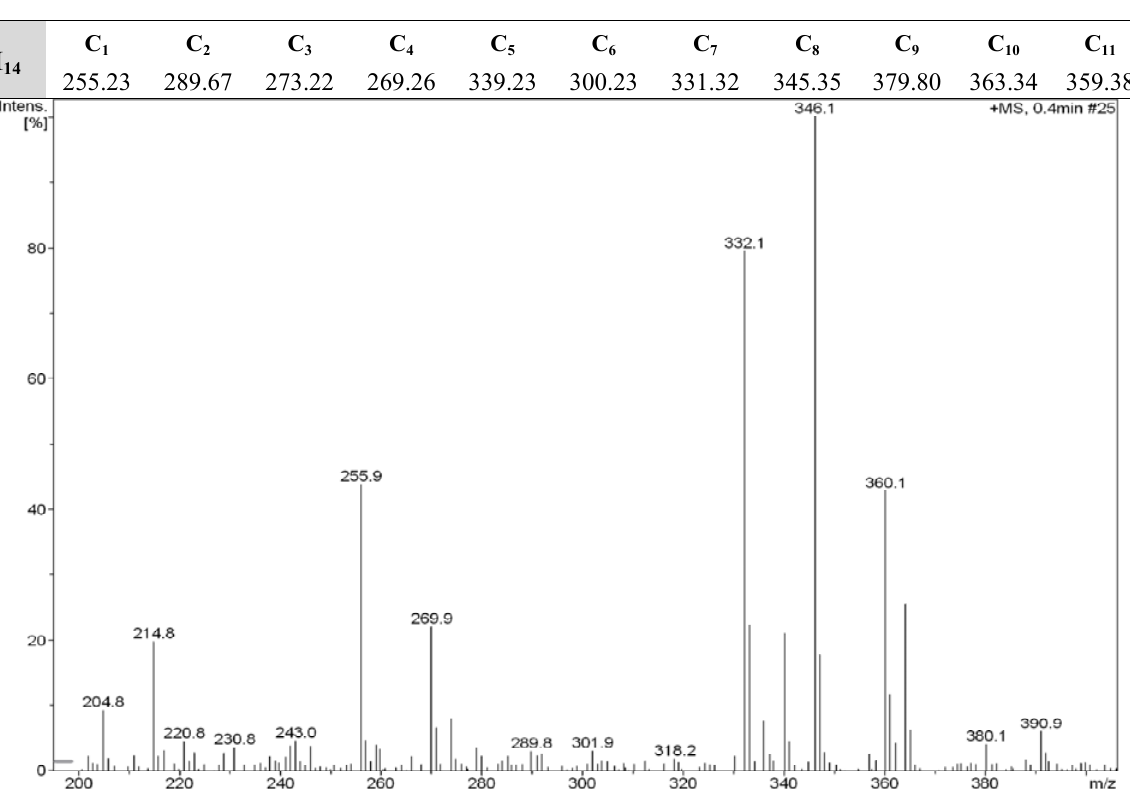
Figure 2. DART-MS of M